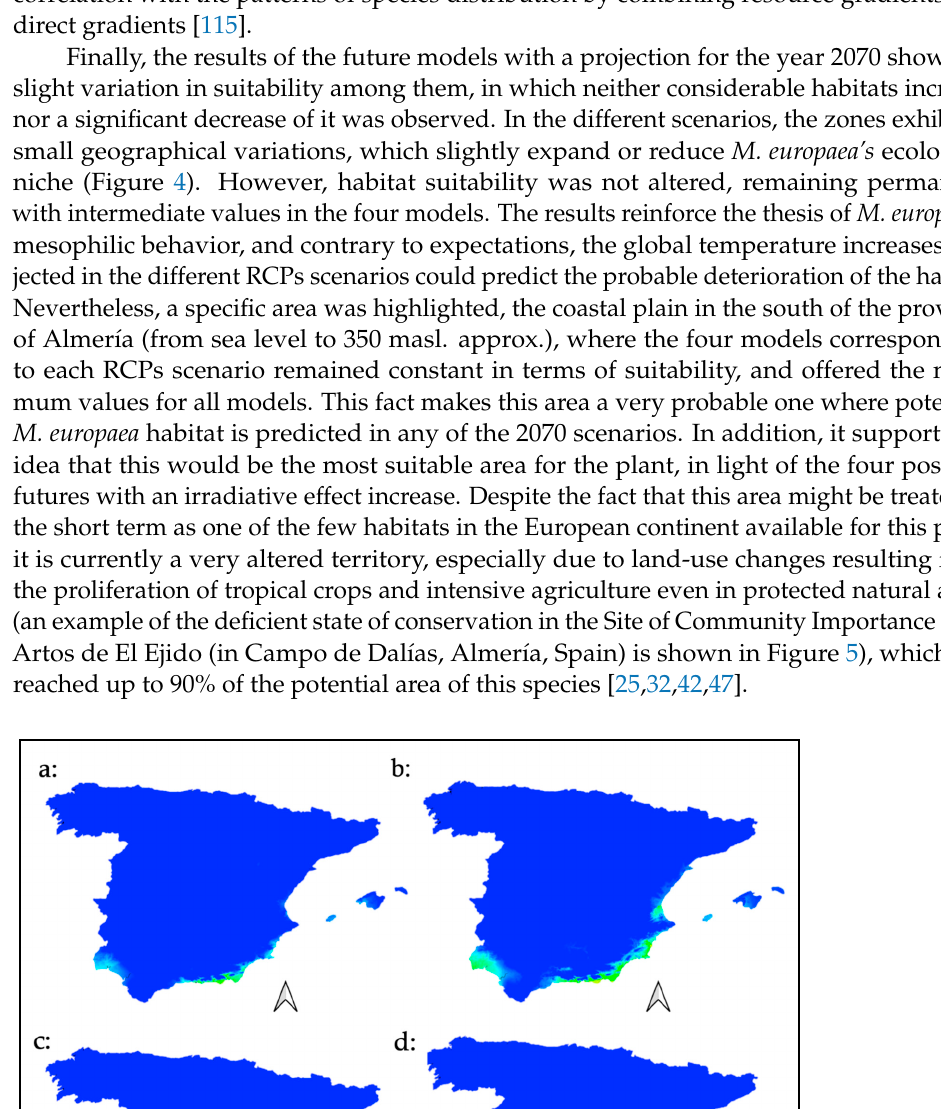
Figure 5. Land changes in the Site of Community Importance (SCI) ES611001 (Artos de El Ejido), sited in Campo de Dalías (Almería). Evolution of M. europaea habitat loss inside this SCI from 1956 to the present.